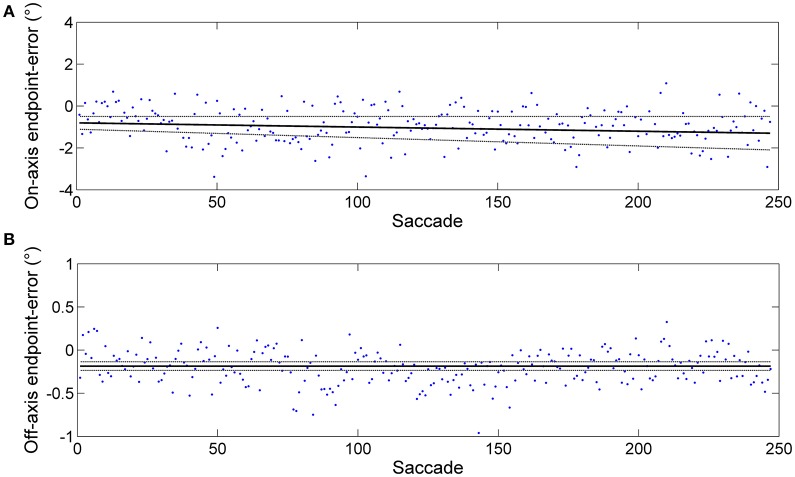
Example of an endpoint-error time series obtained from horizontal predictive saccades made by a representative subject. Data from rightward saccades are shown. The data were fitted using the linear polynomial equation: endpoint-error = slope × saccade + const. The 95% prediction bounds are indicated (broken curve). (A) Plot of endpoint-errors in the directions along target motion (on-axis) vs. trial number: slope = −0.002 ± 0.002 and const = −0.805 ± 0.303. (B) Plot of endpoint errors in the direction orthogonal to target motion (off-axis) vs. trial number: slope = −0.000 ± 0.000 and const = −0.186 ± 0.050. Despite generating a large number of predictive saccades (500, in this case), subject performance appears at least weakly stationary (constant mean and, to a close approximation, constant variance).